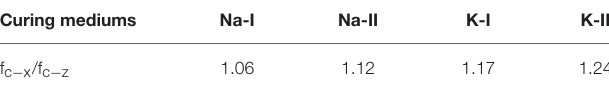
TABLE 4 | Anisotropy in the compressive strength of the heat cured 3D printed